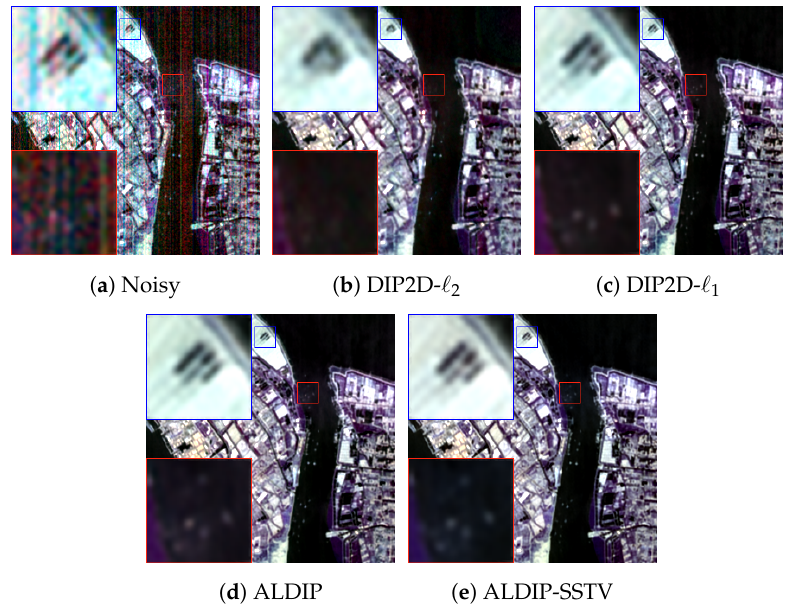
Figure 2. Comparison of DIP2D- (cid:96) 2 (2D convolution DIP with (cid:96) 2 loss) and DIP2D- (cid:96) 1 (2D con- volution DIP with (cid:96) 1 loss) on the real-world HSI Shanghai dataset. Two local areas (red and blue squares) are demarcated zoomed for easy observation. ( a ) Real-world noisy HSI Shanghai (The enhanced pseudo images consisted of the 152nd, 89th and 43rd bands). ( b ) DIP2D- (cid:96) 2 method denoising result. ( c ) DIP2D- (cid:96) 1 denoising result. ( d ) ALDIP method denoising result. ( e ) ALDIP-SSTV method denoising